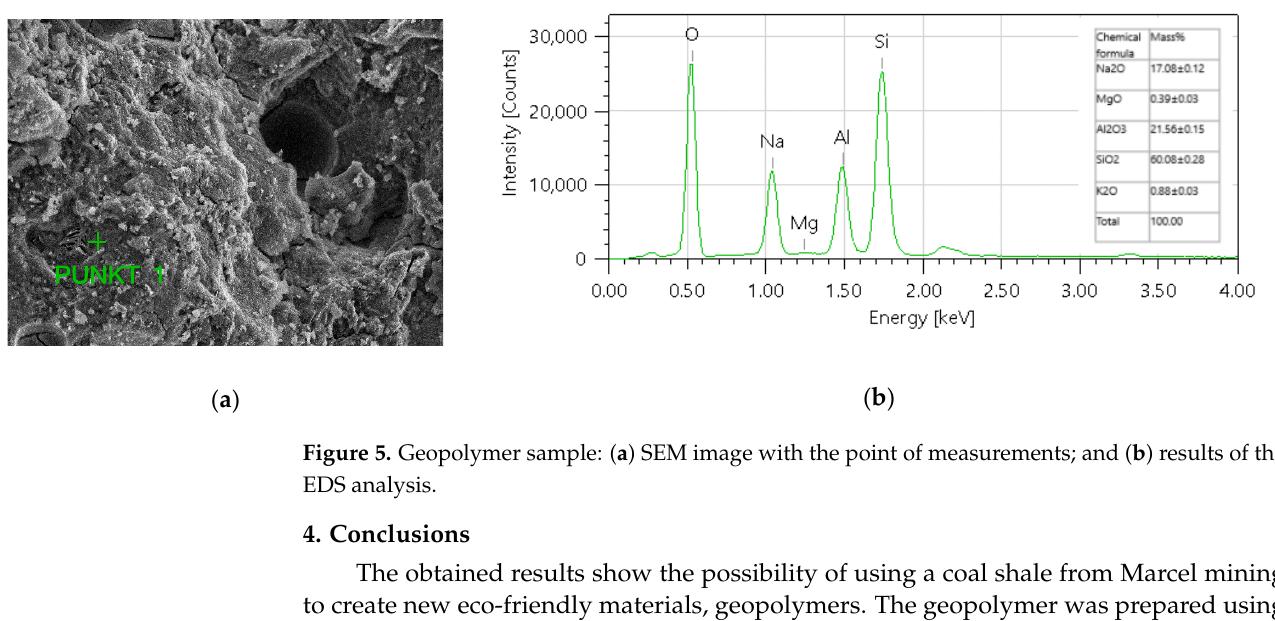
Figure 5. Geopolymer sample: ( a ) SEM image with the point of measurements; and ( b ) results of the EDS analysis.